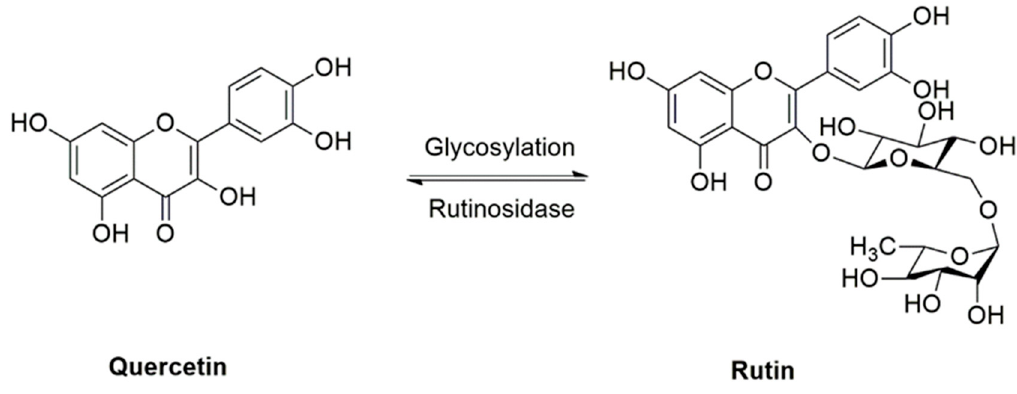
Figure 1. Rutin, a glycoside from quercetin flavonoid.